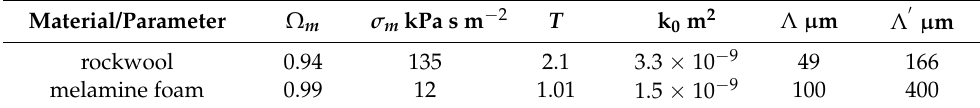
Table 1. JCAL model parameter values assumed for rockwool [2] and melamine foam [9].